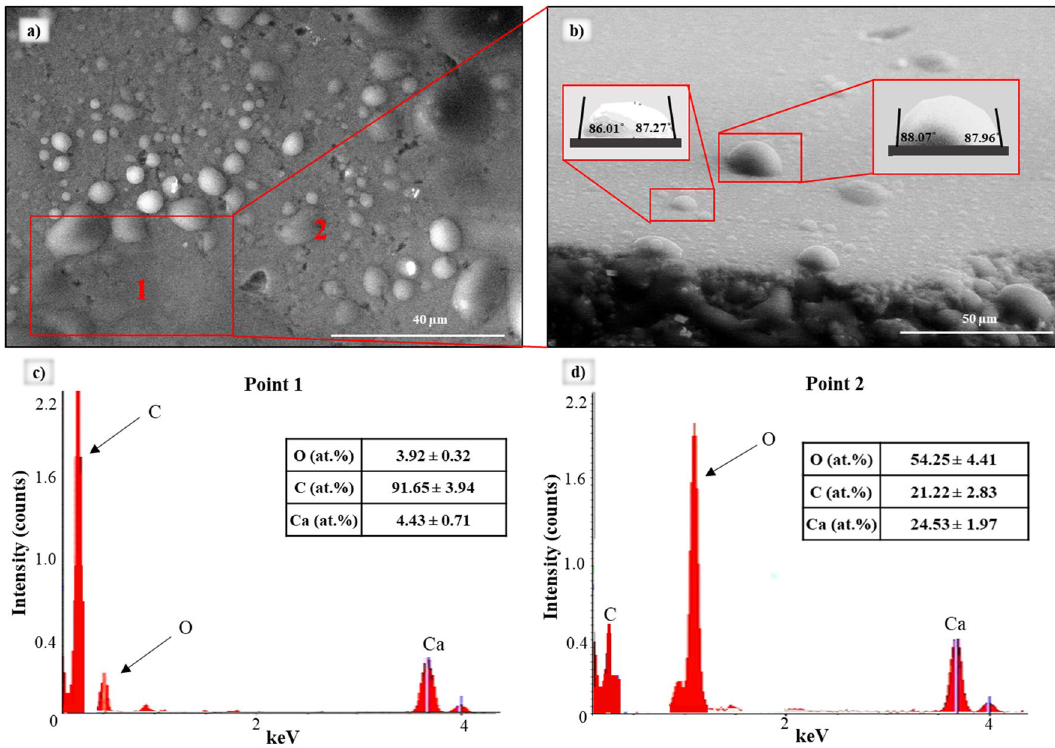
Figure 3. ( a , b ) ESEM images of a water condensation experiment showing formed water droplets on a calcite surface after aging with palmitic acid; EDX spectra of 1st point ( c ) and 2nd point ( d ) of surface, illustrating the element concentrations. Points 1 and 2 represent areas marked in ( a ) that correspond to hydrophobic and hydrophilic surface zones, respectively. The chamber temperature and pressure were held at 0 °C and 850 (identified by the EDX spectra of the specimen’s cross-section). Hydrophobic samples surfaces were cut by Cryo– FIB (see “Methods” section for detailed procedure). Subsequently, S/TEM and EDX analyses were performed, and the thickness and elemental composition of the layers were measured (Figs. 4 and 5). The combination of these techniques revealed fundamental wettability information at the nano-scale. Once the cross-section specimens were cut and covered with the protection layer of platinum, the thickness was calculated by analyzing the EDX element mapping approach (Fig. 4). The high-angle annular dark-field imaging (HAADF) and EDX mapping revealed the presence of the acids layers on the calcite surface (Figs. 4a,c and 5a–d). Clearly, the thickness of adsorbed acid layer varied, and thus the largest thickness was estimated. Owing to the changes in elemental composition spectra (Figs. 4e and 5e,f), the thickness was calculated as a difference between the highest and lowest peaks of a carbon signal. Using this criterion, the thickness of the palmitic, stearic and naphthenic acids was estimated as 85 ± 5 nm, 70 ± 8 nm and 50 ± 5 nm, respectively. Note that these layers were hydrophobic, and other hydrocarbons (e.g., from oil) can efficiently adsorb onto them and form longer and thicker layers. The thickness of the naphthenic acid layer was the smallest among the tested acids, which is consistent with the surface wettability results (weakly water-wet with a contact angle of 67.91° ± 5.43°). Carboxylic acids bind to a calcite surface via a condensation reaction 38 . Indeed, H + ions (from the acid) approach the surface carbonate ion, whereas palmitic, stearic and naphthenic anions are attracted to the primary surface centers—Ca 2+ ions (Fig. 6). However, due to the steric effects and different conformation of hydrocar- bon chains, some surface-active centers can be blocked for acids molecules approaching. As a result, the acids adsorption is irregular on the calcite surface (Fig. 1). Furthermore, aging in naphthenic acid revealed a less significant hydrophobization effect of calcite surfaces than palmitic and stearic acids. This can be explained by taking into account the difference in the molecular structure of acids. As such, palmitic and stearic acids have liner molecular configurations, whereas naphthenic has a branched structure. Therefore, more surface area is needed for naphthenic acid molecules. The general schematic representation of chemisorption of carboxylic acids is illustrated in Fig. 6. Thus, when the calcite surface is exposed to carboxylic acids, the first adsorbed layer is formed. Consequently, on the first layer, other acid molecules can adsorb through the hydrophobic interactions, as it is shown in Fig. 6, forming layers with different thicknesses.